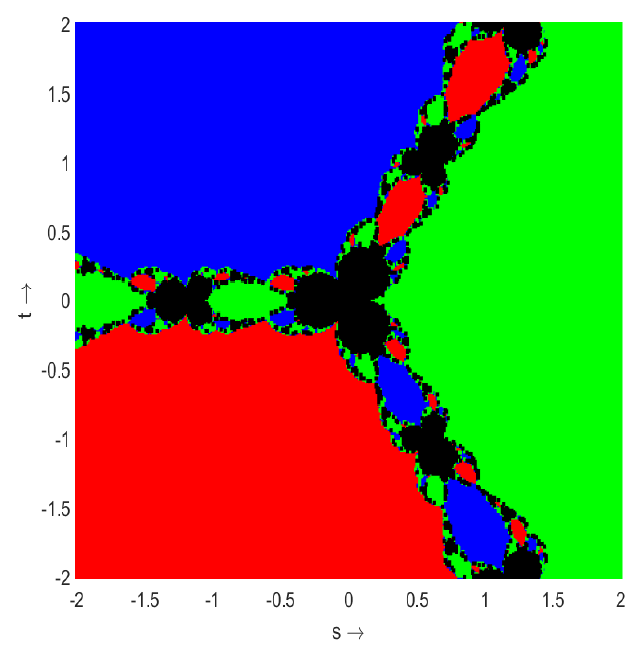
Figure 4. Dynamics of the method (2) associated with BA of Example 5. In Figure 5 (corresponding to Example 5), the red region is the set of all initial points from which the iterate (3) converges to ( − 1/2, − initial points from which the iterate (3) converges to ( − 1/2, is the set of all initial points from which the iterate (3) converges to ( 1, 0 ) . The black region represents the Julia set.